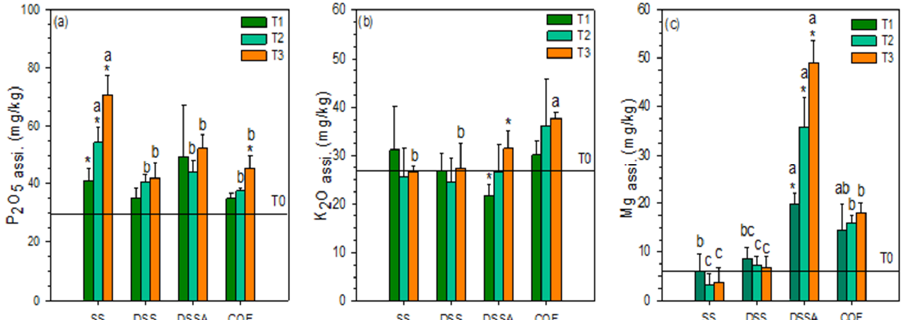
Figure 6. Macronutrients content in the soil after lettuce growth for the different soil amendments: ( a ) assimilable phosphorus; ( b ) assimilable potassium; ( c ) assimilable magnesium (T0—0 kg N/ha; T1—85 kg N/ha; T2—170 kg N/ha; T3—255 kg N/ha; mean values and standard deviations obtained in four replicates of each treatment; different letters indicate statistical differences between the added soil amendments; * indicate statistical differences between treatment within each added material; the statistical analysis was conducted separately for each figure).